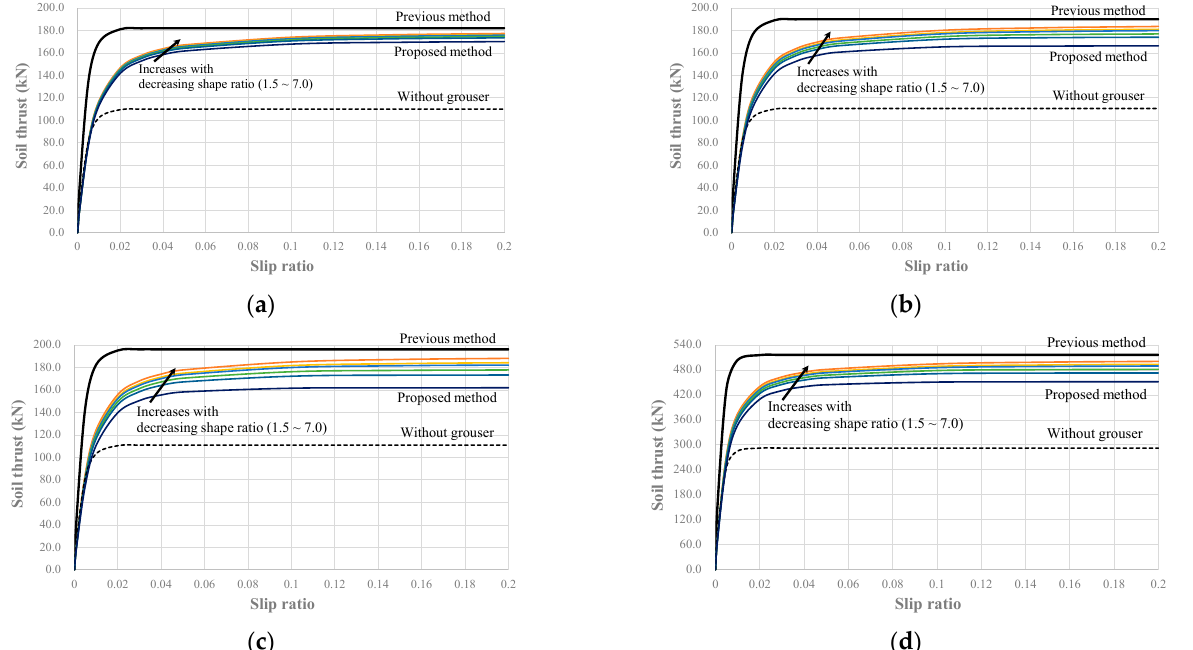
Figure 7. Soil thrust and slip displacement curves in soils exhibiting hardening behavior ( c = 1.39 kPa, 𝜙 = 30.6° , K = 1.13): EC145E with a grouser height of ( a ) 25 mm, ( b ) 50 mm ( c ) 70 mm: ( d ) EC380E with 70 mm grouser height.